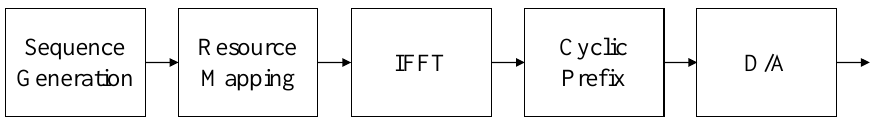
Figure 2. The procedure of 5G baseband signal generation.